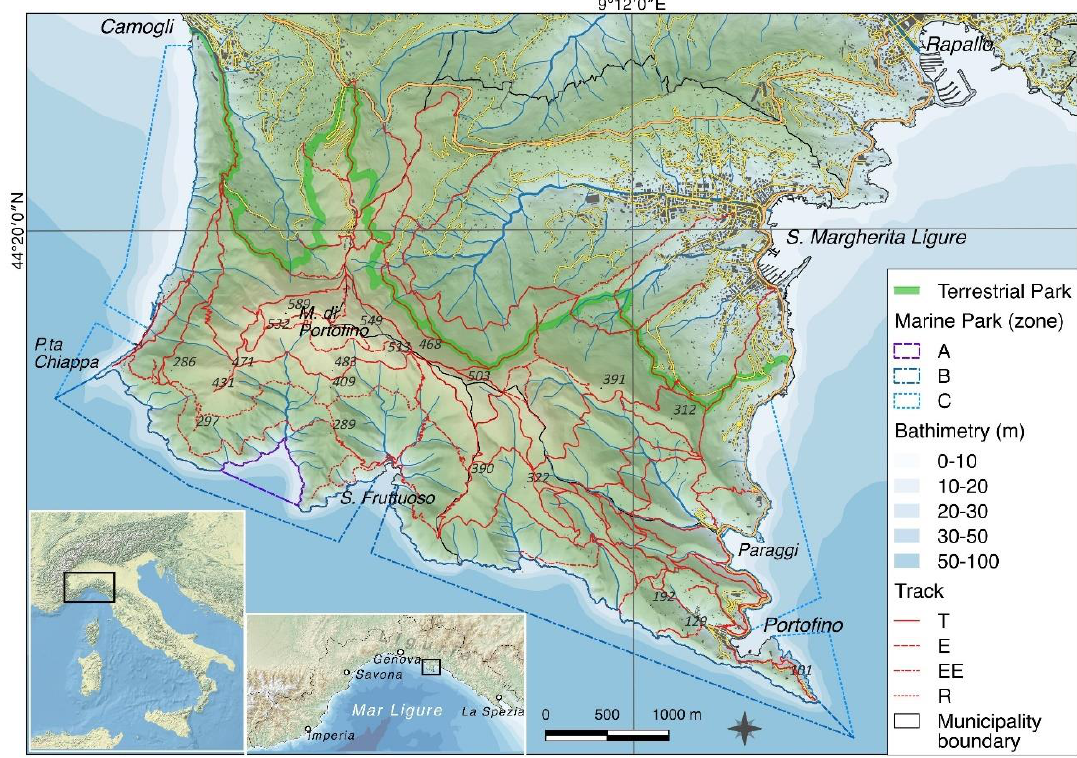
Figure 1. Location map of the study area (modified from [11]).